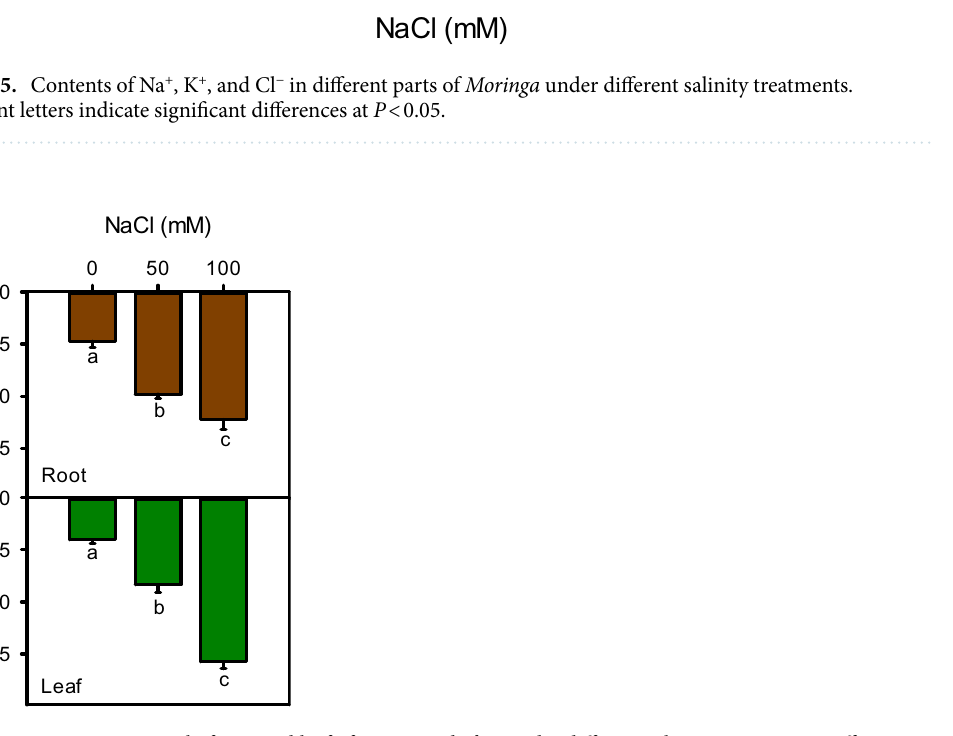
Figure 6. Osmotic potential of root and leaf of Moringa oleifera under different salinity treatments. Different letters indicate significant differences at P <